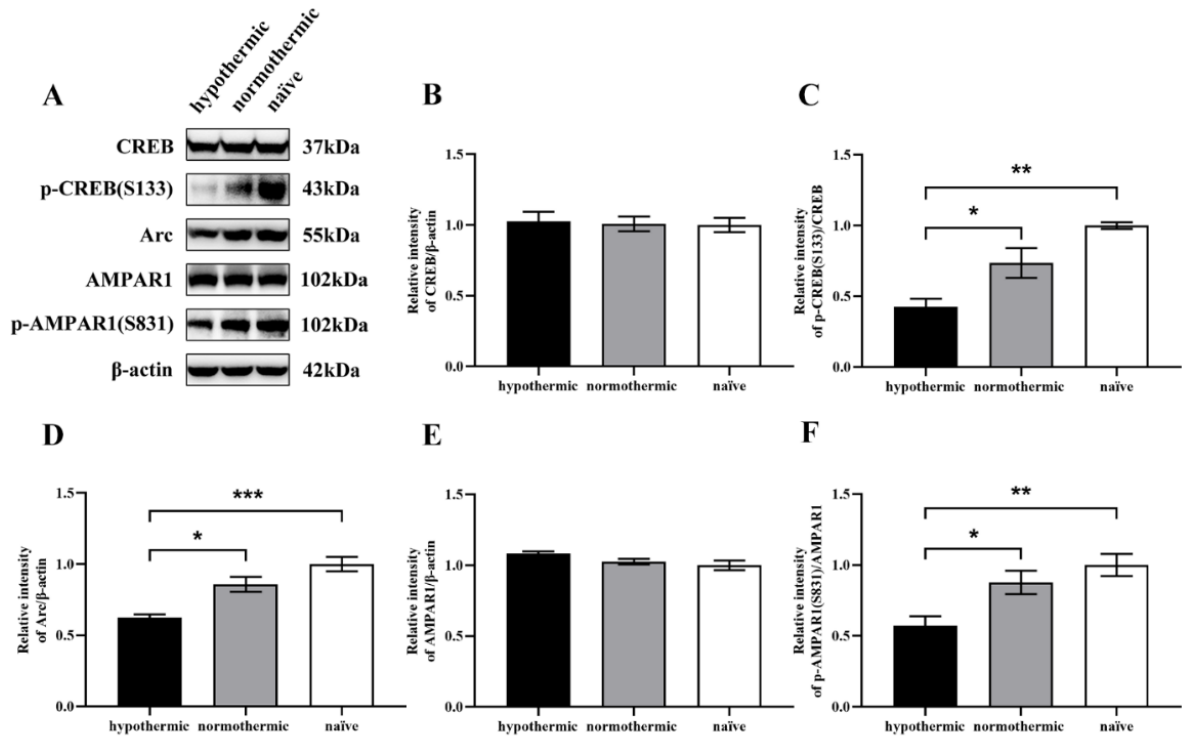
Figure 5. Expression levels of hippocampal synaptic plasticity-related proteins in rats and the effects of intraoperative hypothermia. ( A ) The visualisation of protein bands of CREB, p-CREB (S133), Arc, AMPAR1, p-AMPAR1 (S831), and β -actin; ( B ) quantitative analysis of CREB expression levels normalised to β -actin band intensities; ( C ) quantitative analysis of p-CREB (S133) expression levels normalised to CREB band intensities; ( D ) quantitative analysis of Arc expression levels normalised to β -actin band intensities; ( E ) quantitative analysis of AMPAR1 expression levels normalised to β -actin band intensities; ( F ) quantitative analysis of p-AMPAR1 (S831) expression levels normalised to AMPAR1 band intensities. Data are expressed as mean ± SEM. * p < 0.05, ** p < 0.01 and *** p < 0.001, n = 3–4.